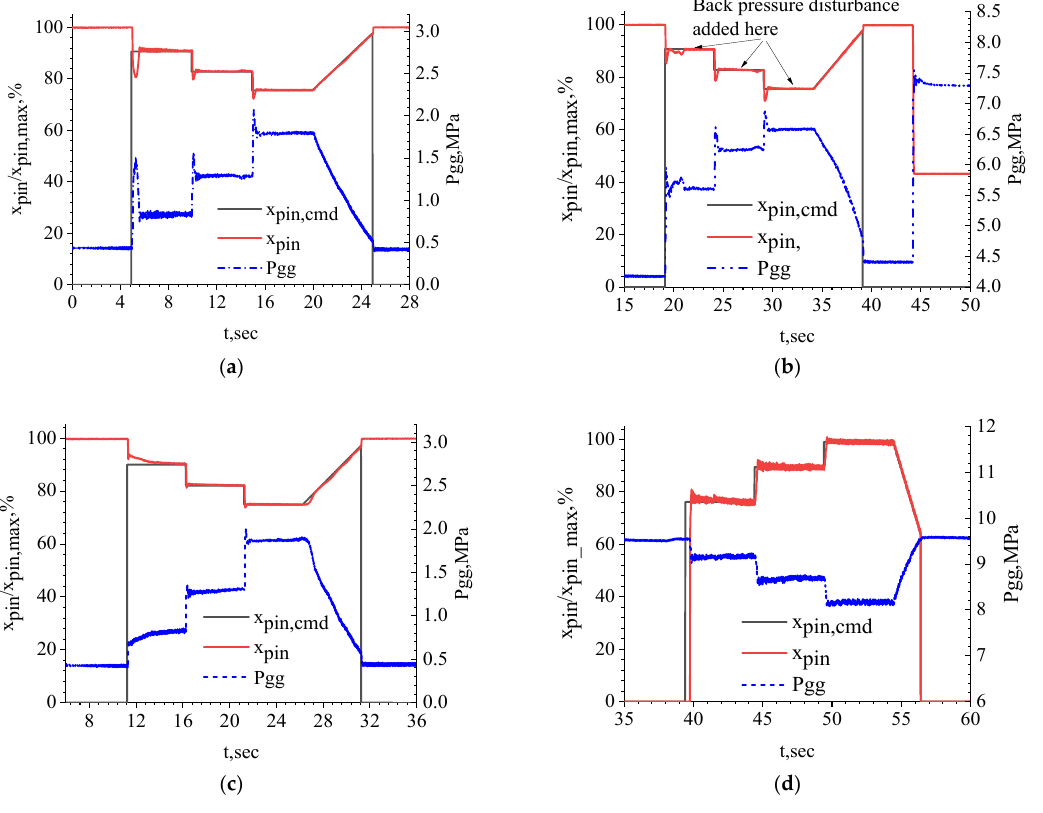
Figure 10. Test results of the variable-thrust control system. ( a ) XC-001. ( b ) XC-002. ( c ) XC-003. ( d ) XC-004. Table 2. Summary of control system performance.